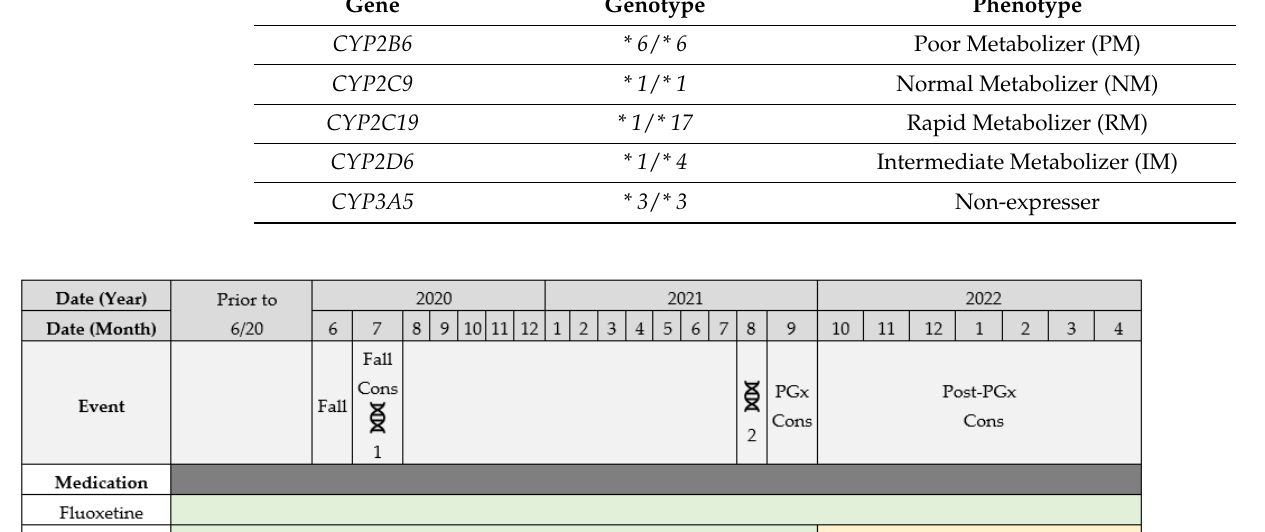
Table 2. PGx results.